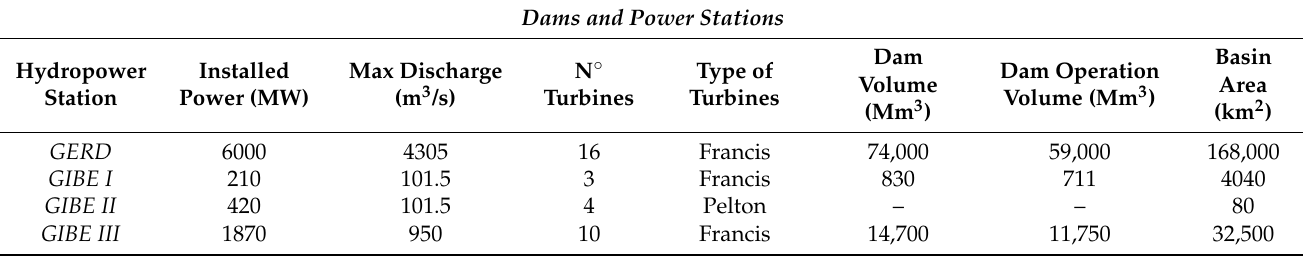
Table 1. Characteristics of hydropower stations and related dams. Dams and Power Stations